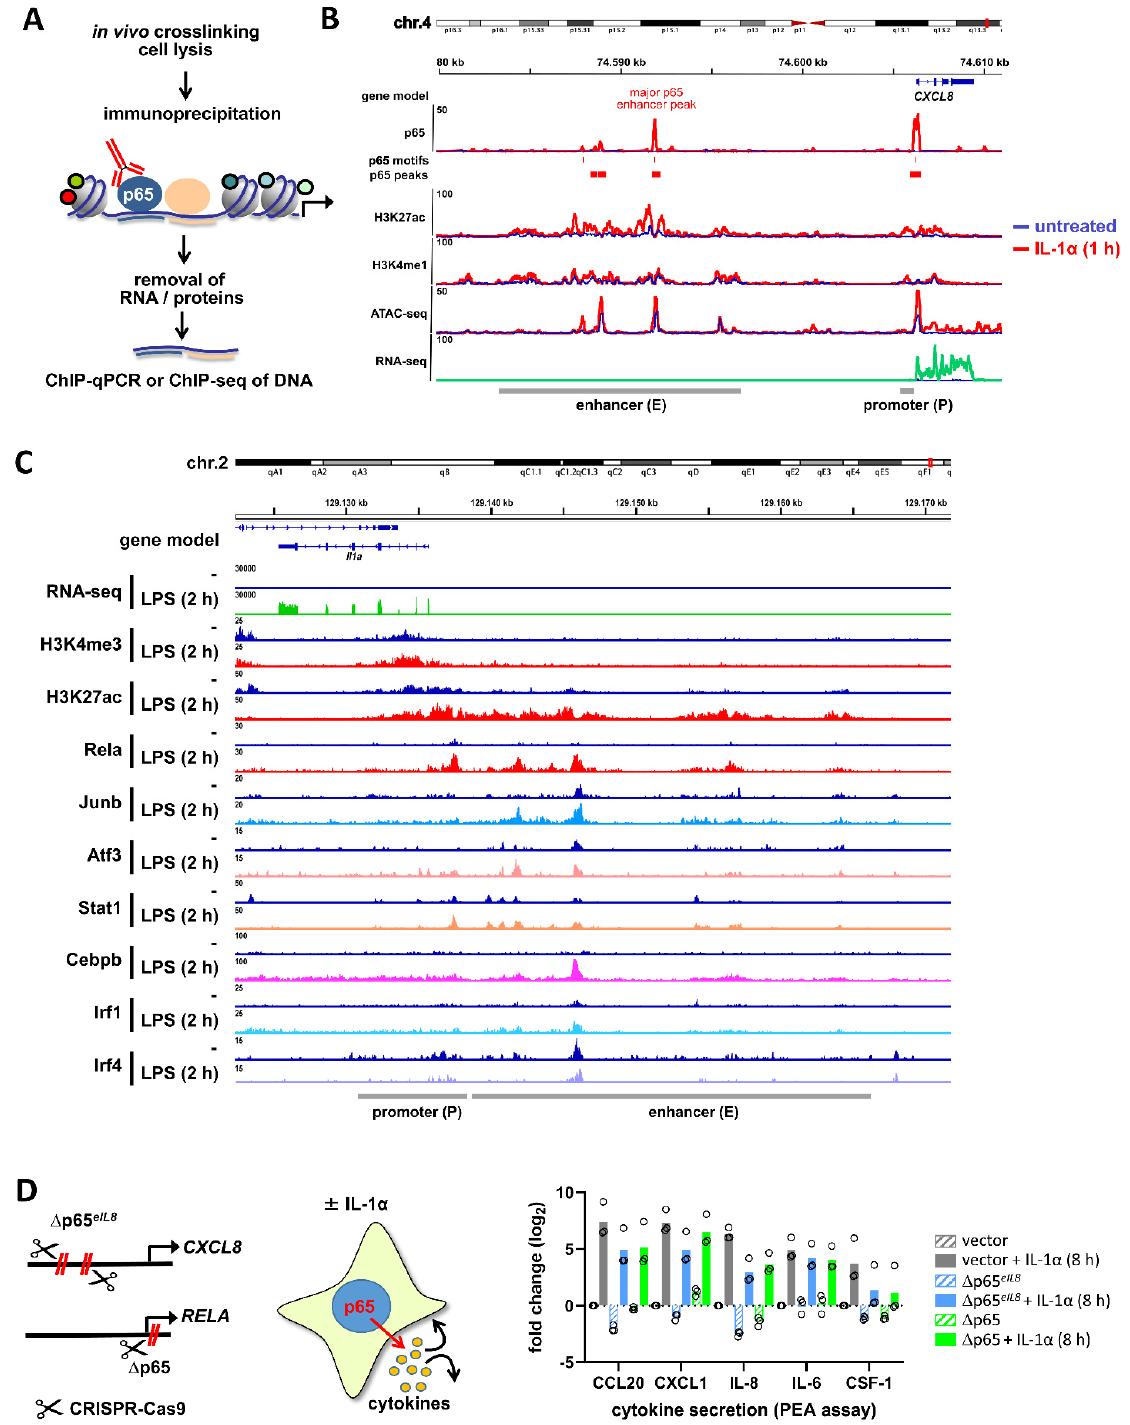
Figure 6. ChIP-seq, ATAC-seq, RNA-seq and genome editing to monitor the nuclear NF- κ B pathways and their relevance for gene expression. ( A ) Principle of ChIP-qPCR or ChIP-seq assays. ( B ) Integrative genomics viewer (IGV) genome browser views of combined ChIP-seq, ATAC-seq, and RNA-seq analyses of the extended human CXCL8 locus before (blue profiles) and after short-term stimulation with IL-1 α (red, green profiles) to reveal (i) the genomic binding sites of p65 to enhancers and promoters, (ii) the presence of active enhancers (defined by inducible H3K27ac and constitutive H3K4me1), (iii) the regions of open or accessible chromatin (by ATAC-seq), and (iv) the resulting mRNA expression of the NF- κ B target gene CXCL8 . The figure was generated using published data from our laboratories [62,65]. The data can be retrieved from NCBI GEO (https://www.ncbi.nlm.nih.gov/geo, accessed on 12 October 2021) with the accession numbers GSE64224 and